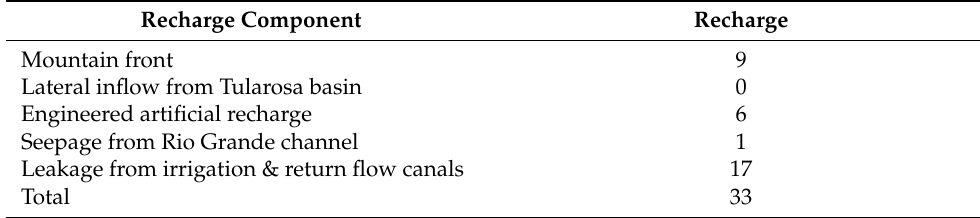
Table 2. Annual recharge rates for the Hueco Bolson (kAF). Recharge Component Recharge Mountain front